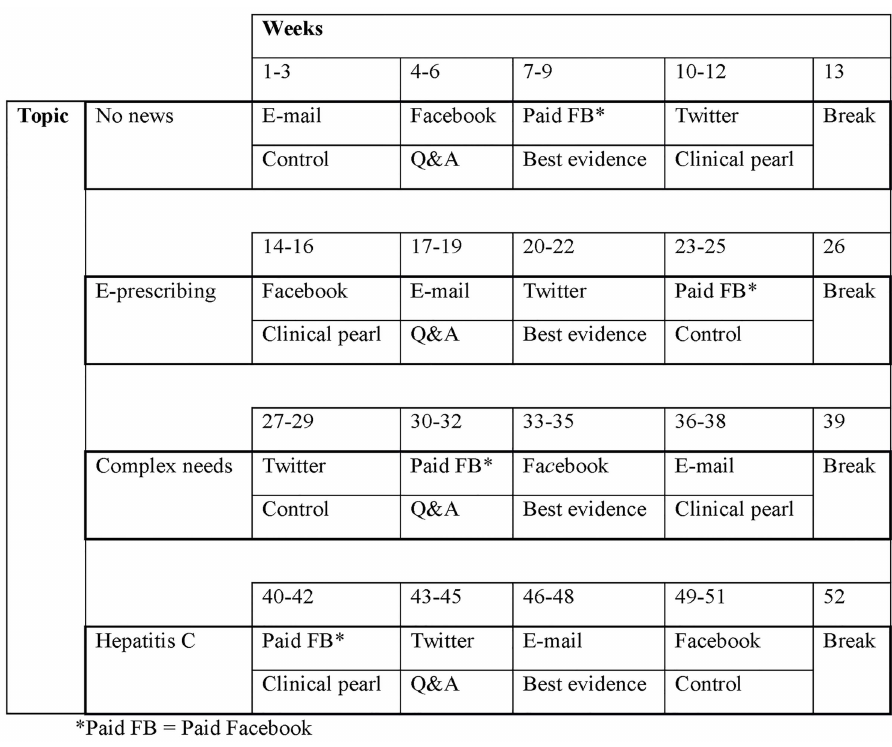
Fig 1. Intervention